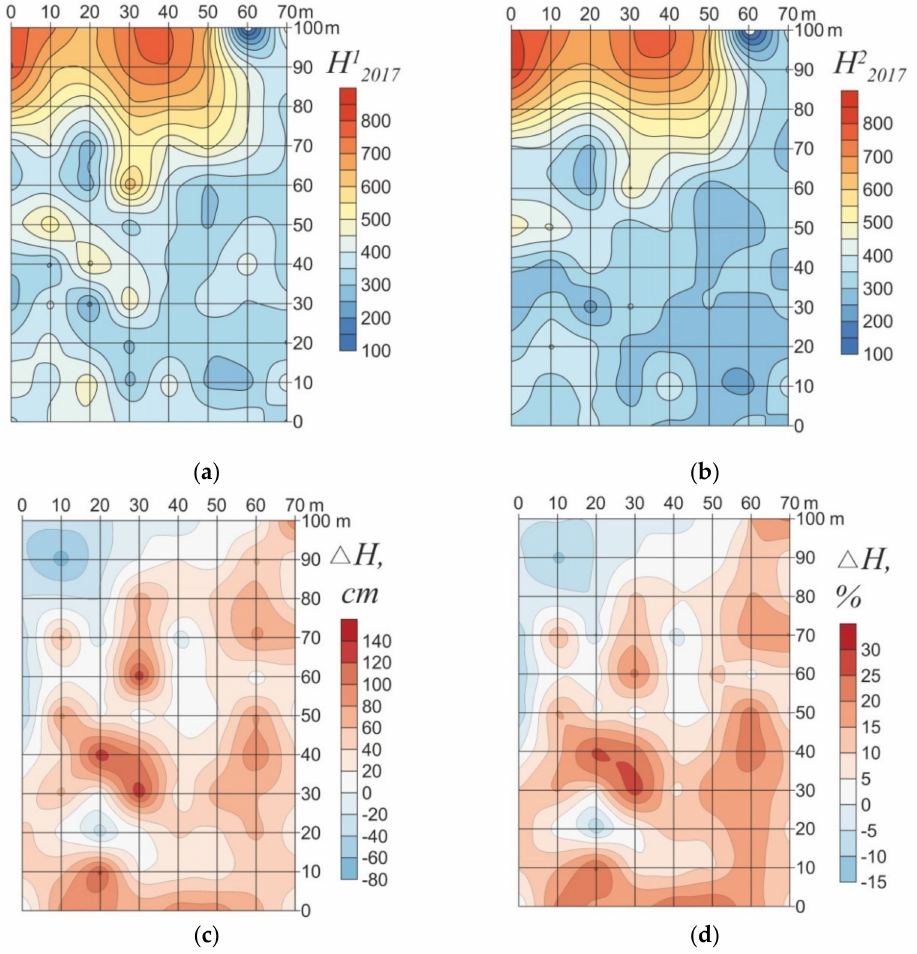
Figure 7. Depth ( H ) of the permafrost table at the Kumzha site (CALM R24A-2) in 2017: ( a ) H 1 2017 — according to the GPR data taking into account the changes in velocity at the site, ( b ) H 2 2017 —without taking into account the velocity measurements at the site (velocity 7 cm/ns determined according to the hyperbole on one of the profiles), ( c ) ∆ H —absolute difference between the depths H 1 2017 and H 2 2017 , cm, ( d ) ∆ H —relative difference between the depths H 1 2017 and H 2 2017